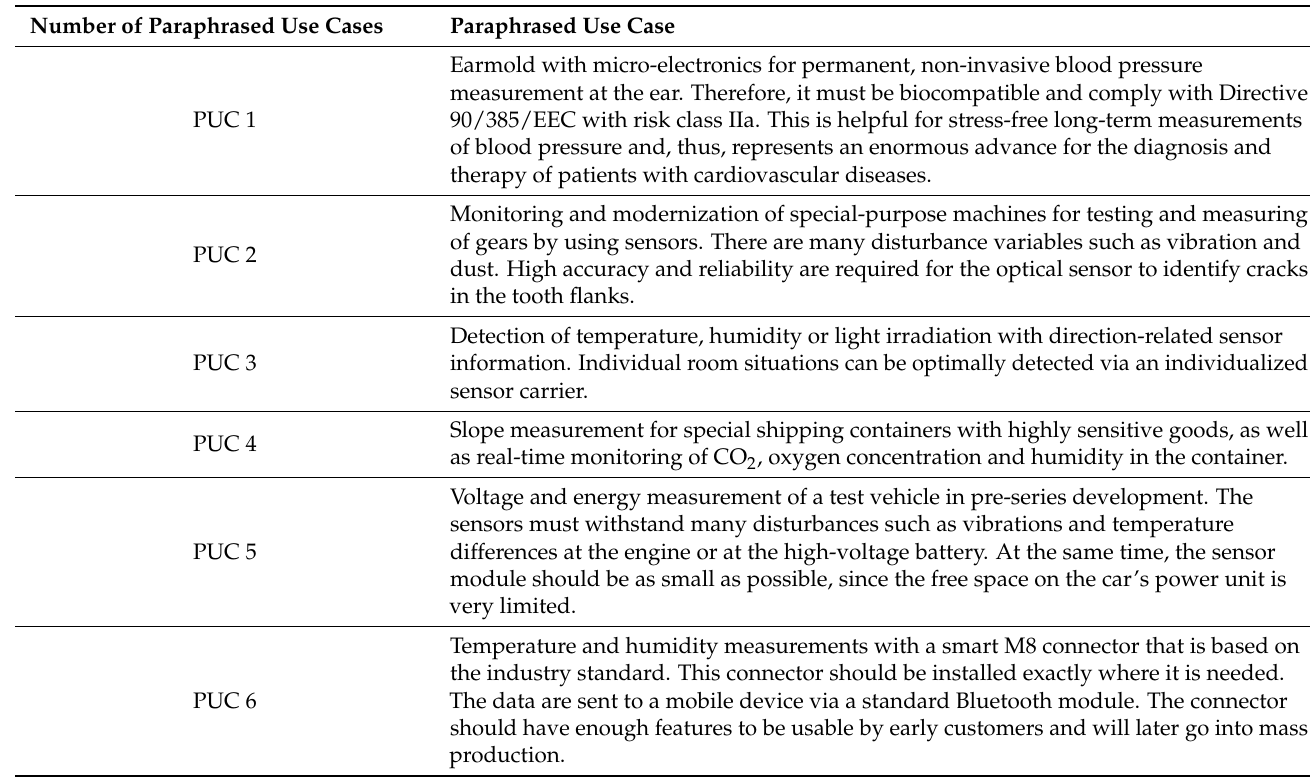
Table 1. Paraphrased use